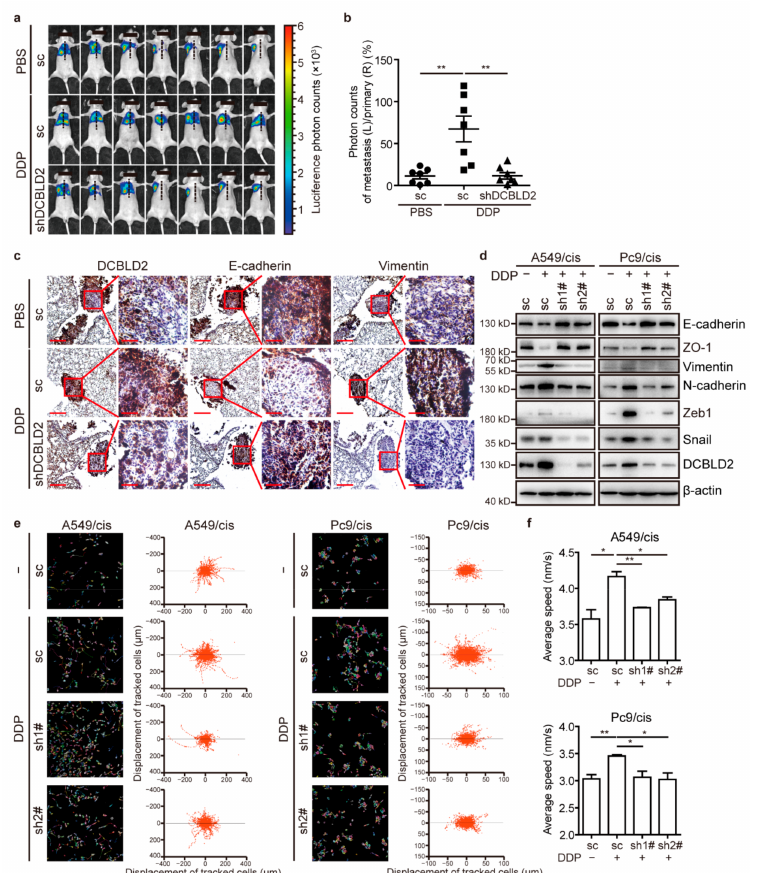
Figure 4. DCBLD2 mediates cisplatin-induced EMT and tumor metastasis. ( a , b ) A total of 1 × 10 6 Pc9/cis-luciferase cells transfected with shDCBLD2 or scramble control were inoculated into the right lungs of BALB/c nude mice ( n = 7 per group). On day 7, mice were intraperitoneally injected with 4.0 mg/kg cisplatin or an equivalent volume of PBS every 7 days. Thirty-five days after inoculation, mice underwent a bioluminescence test and were sacrificed. The primary tumors in the right lung and the metastatic foci in the left lung were subjected to HE staining or IHC staining. Bioluminescence imaging is shown in ( a ), and quantitation of bioluminescence signals is shown in ( b ). ( c ) Representative IHC images of E-cadherin and Vimentin expression in paraffin-embedded serial sections of the primary lesion (right lung) of orthotopically implanted mice from Figure 3A. Scale bar: 200 µ m (left) and 50 µ m (right). ( d ) Western blot assay to confirm the effect of DCBLD2 on EMT in cisplatin treatment. Cells with stable DCBLD2 knockdown or scramble control were cultured in the presence or absence of 2 µ g/mL cisplatin for 24 h. ( e , f ) Dynamic imaging analyses of cell migration in stable DCBLD2 knockdown cells and scramble control cells pretreated with 2 µ g/mL cisplatin or vehicle control for 24 h. Cell migration was measured over 16 h by HCS. Representative images recording the single-cell motion track (left panel) and single-cell ultimate displacement (right panel) are shown in ( e ), and the average speed was measured by Harmony in ( f ). * p < 0.05, ** p < 0.01, t -test. DDP, refers to cis-diamminedichloridoplatinum (II), also known as cisplatin or